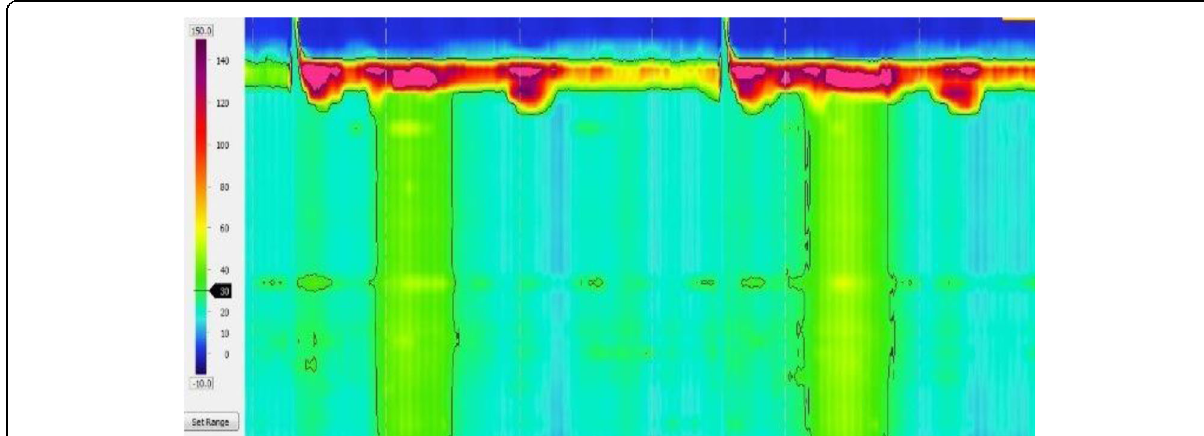
Fig. 3 High-resolution manometry (HRM) findings before surgery in Case 1. Although the tip of the catheter could not to be placed inside the stomach